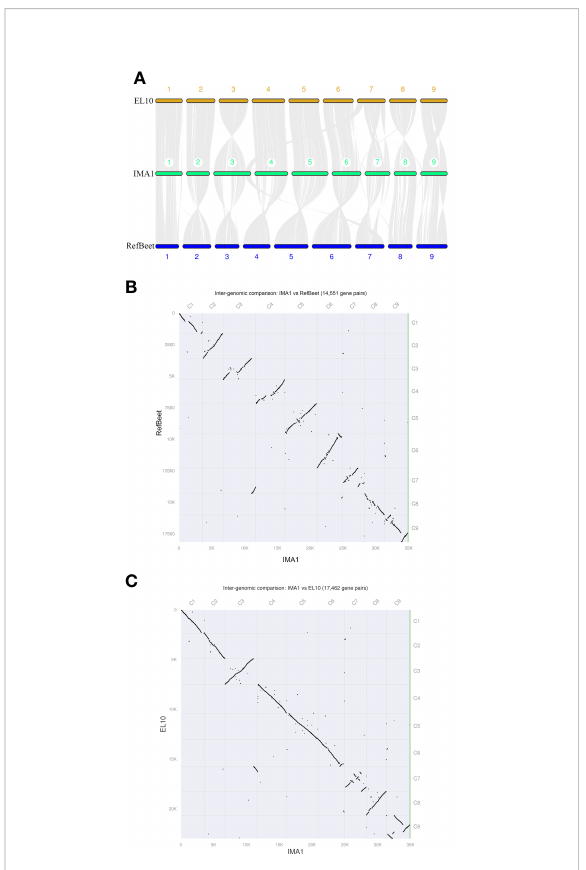
FIGURE 3 Genomic alignment among three genome assemblies of sugar beet lines IMA1, EL10, and RefBeet. (A) Schematic representation of synteny among IMA1, EL10, and RefBeet genomes. Gray lines connect matching gene pairs. (B) Scatter plot of syntenic blocks of conserved genes between Beta vulgaris IMA1 and RefBeet genomes. (C) Scatter plot of syntenic blocks of conserved genes between B. vulgaris IMA1 and EL10 genomes. Chromosome order in the new assembly was determined by length (from largest to smallest). Rightward and downward are 5 ′ to 3 ′ on assembly plus